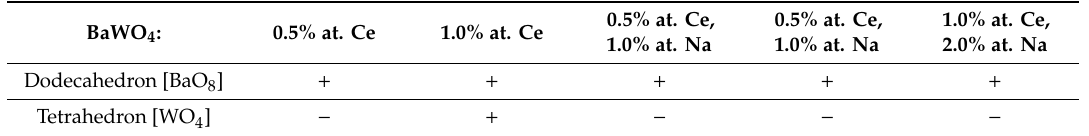
Table 5. Summary data: Ce 3 + ion in the dodecahedron [BaO 8 ] or the tetrahedron [WO 4 ] in BaWO 4 single